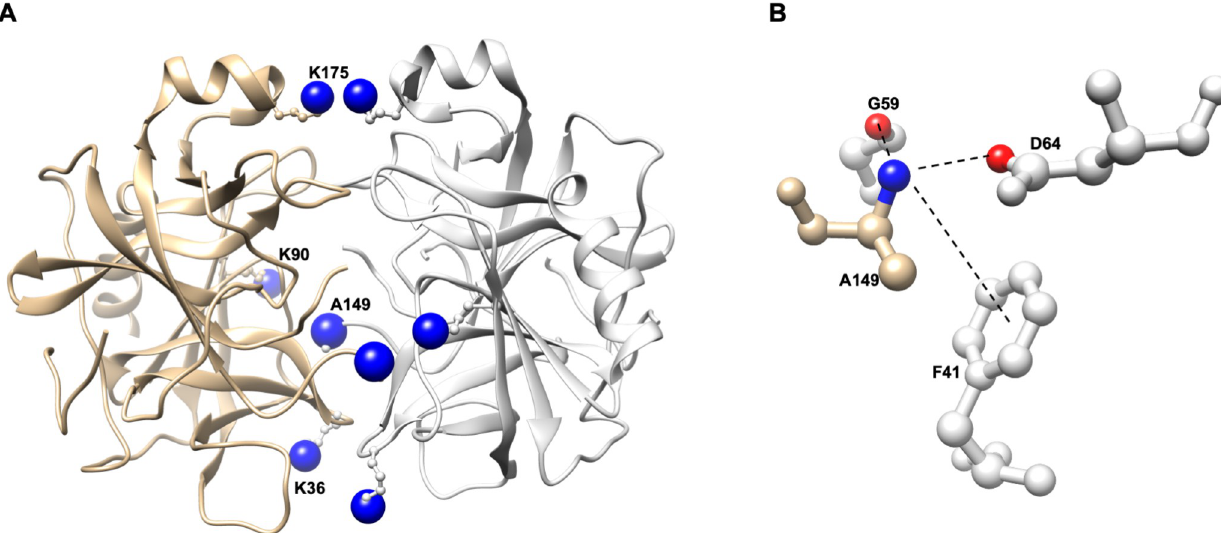
Fig 3. Structure of a-chymotrypsin dimer from Bos taurus (PDB ID: 4CHA) A depicting residues K36, K90, A149 and K175 at the dimer interface, with α – and ε – amino groups shown as blue spheres and each monomer sub-unit coloured tan or light grey; B electrostatic and hydrophobic interaction between α –amino group from A149 with G59, D64 and